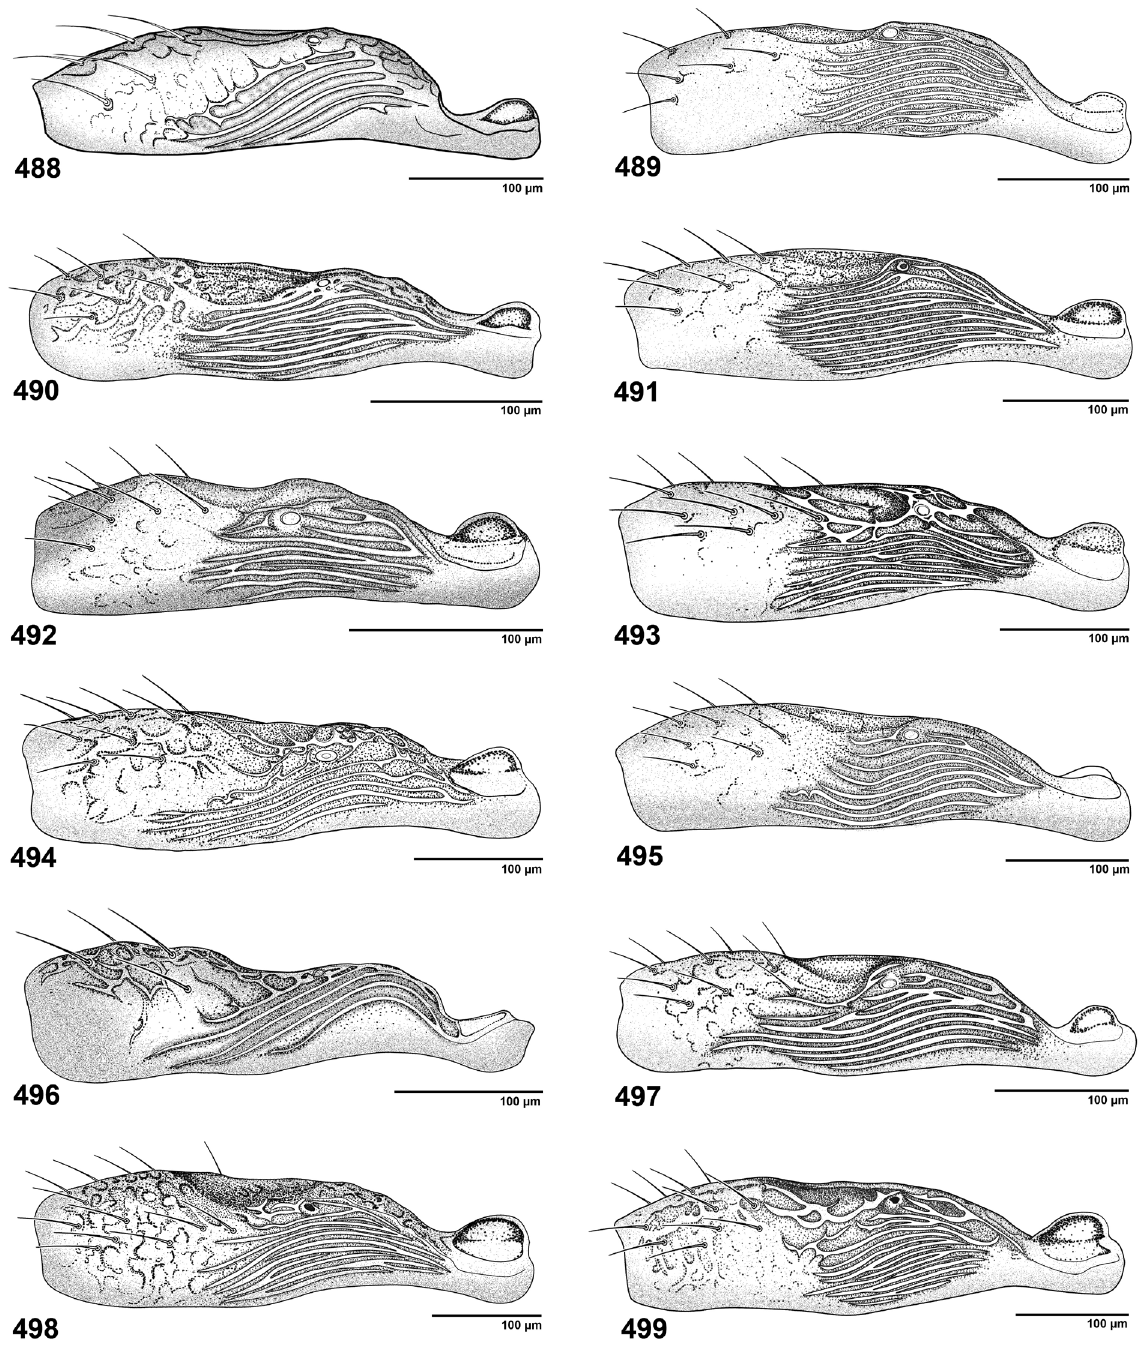
Figs 488–499. Anterolateral aspect of petiole in Aphidius species (♀): 488 . Aphidius platensis